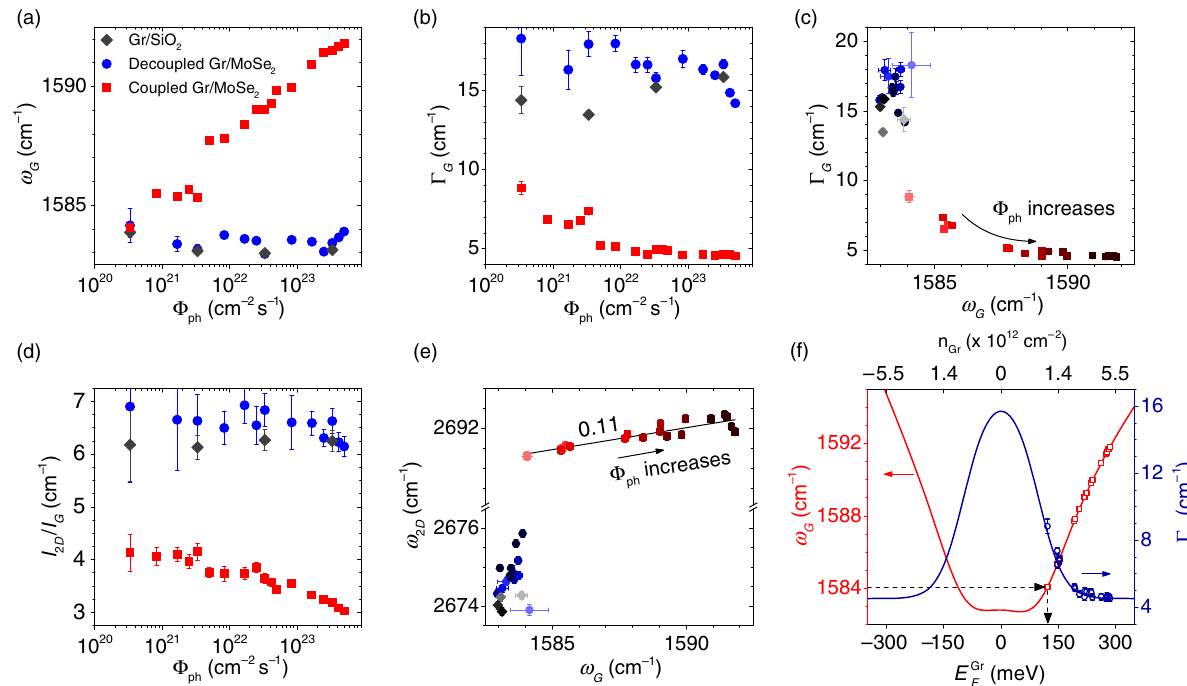
FIG. 3. (a) Raman G -mode frequency ω G and (b) full width at half maximum Γ G recorded at a laser photon energy of 2.33 eV as a function of the incident photon flux Φ for coupled (red squares) and decoupled (blue circles) Gr = MoSe 2 and for Gr = SiO 2 (gray ph diamonds) (see Fig. 1). (c) Correlation between Γ G and ω G under increasing Φ . (d) Ratio between the integrated intensity of the ph 2D-mode feature and that of the G -mode feature I 2 D =I G as a function of Φ . (e) Correlation between ω 2 D and ω G under increasing Φ ph The color of the symbols in panels (c) and (e) gets darker with increasing Φ . (f) ω G (red squares, left axis) and Γ G (blue circles, ph right axis) as a function of the graphene Fermi energy E Gr F and doping level n . The solid lines are theoretical calculations [46,48]. Gr All measurements were performed in ambient